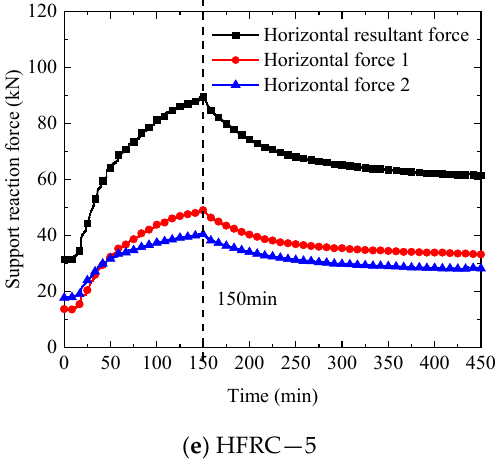
Figure 15. Horizontal support reaction force–time curves: ( a ) RC—1; ( b ) RC—2; ( c ) HFRC—3; ( d